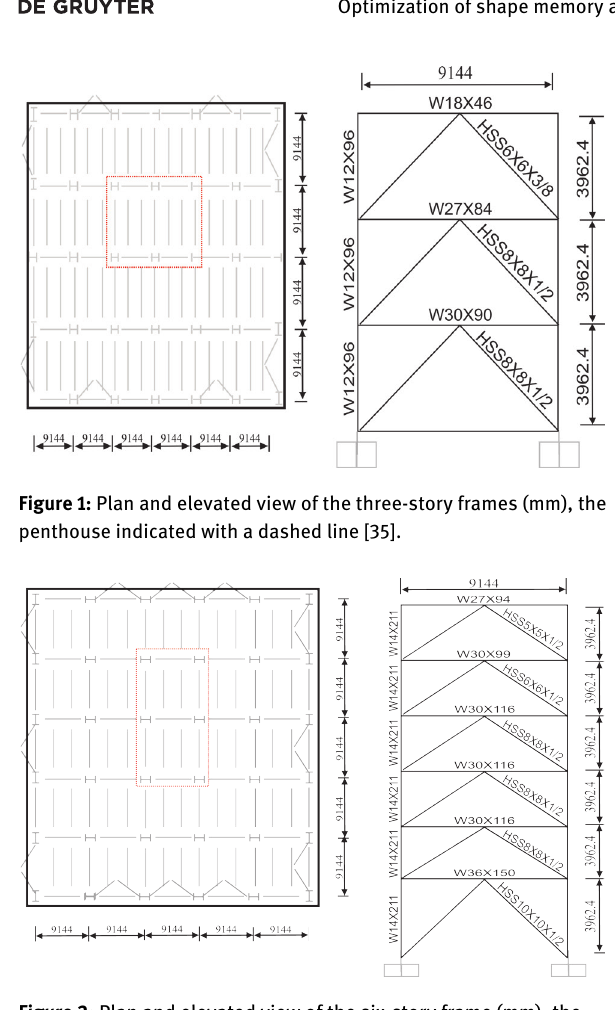
Figure 2: Plan and elevated view of the six-story frame (mm), the penthouse indicated with a dashed line [35].